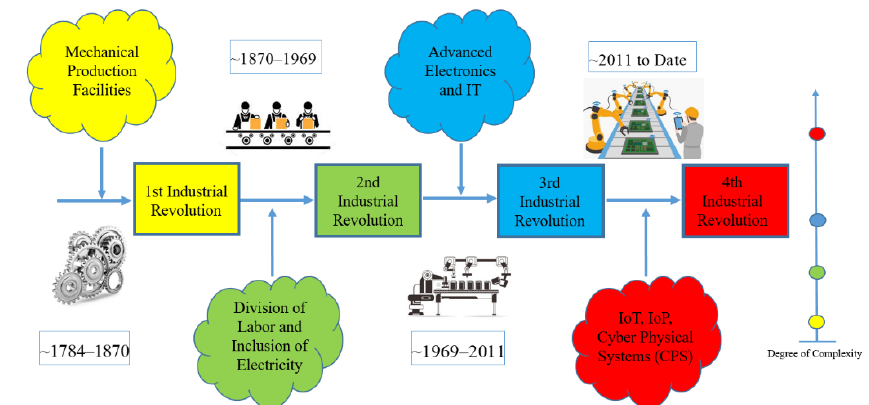
Fig. 1. Trends of industrial